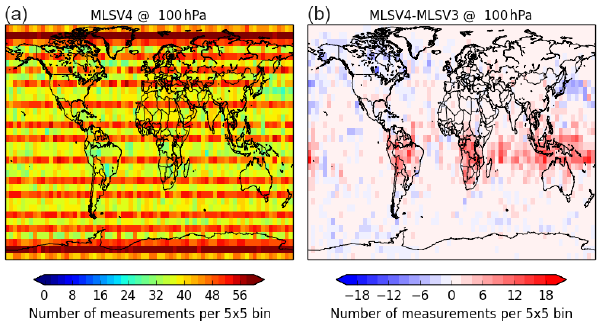
Figure 17. Number of measurements averaged within 5 ◦ × 5 ◦ bins at 100hPa in January 2012 in the MLS V4 data set (a) . Difference between the number of measurements averaged within 5 ◦ × 5 ◦ bins at 100hPa in January 2012 in the MLS V4 and the MLS V3 data sets (b)